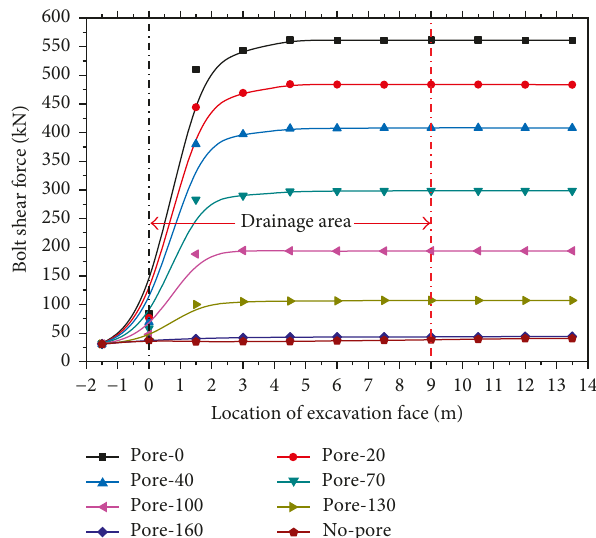
Figure 21: The maximum shear force of bolt.